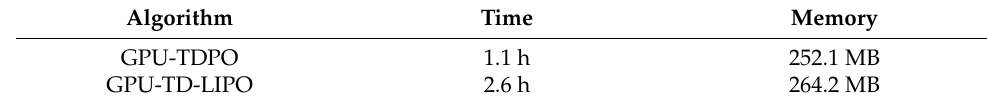
Table 5. Time and memory of each method.